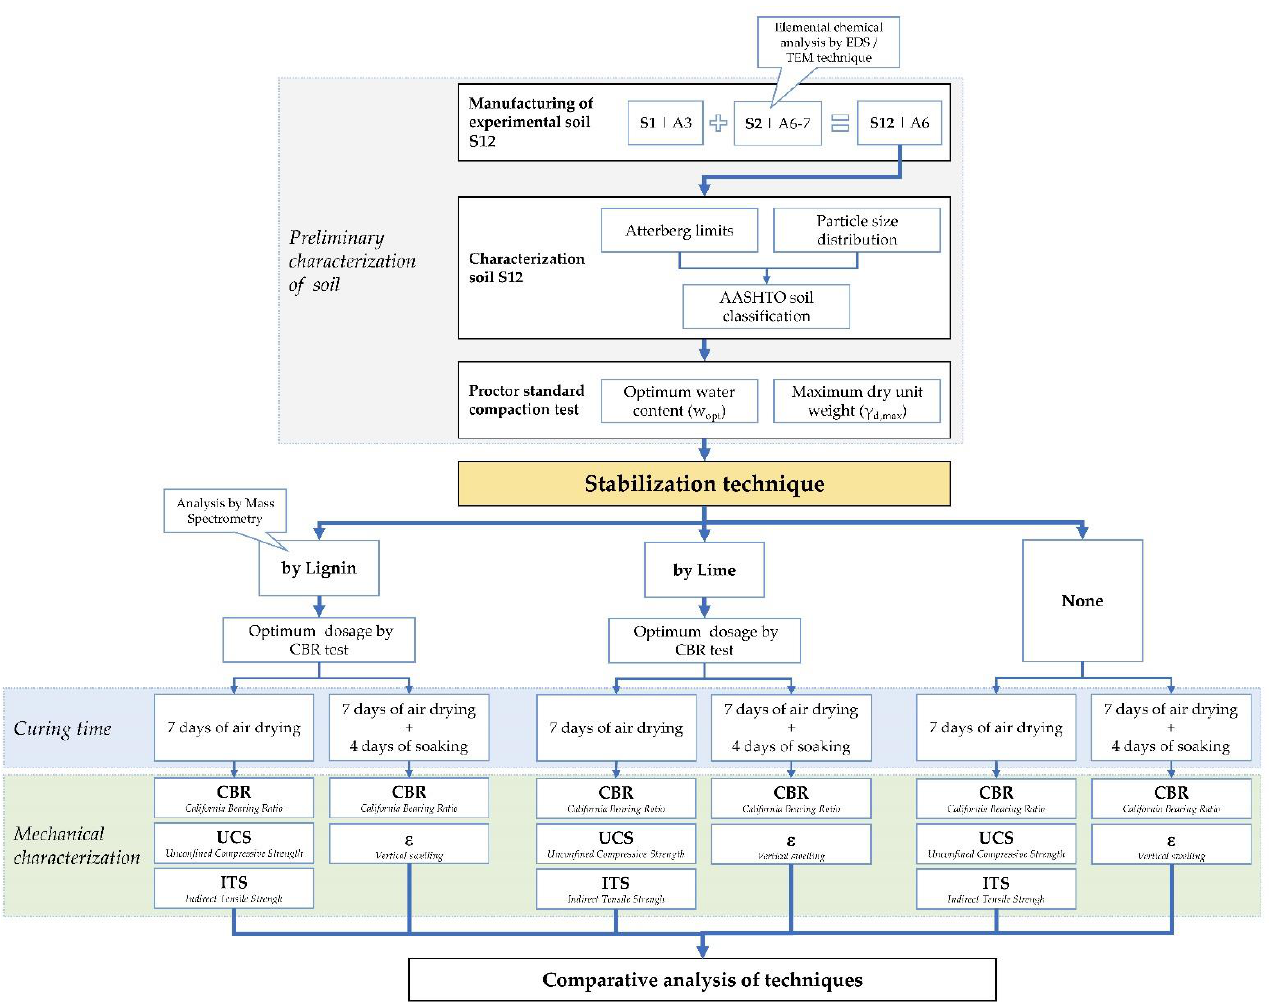
Figure 5. Summary of the experiment design and main activities.